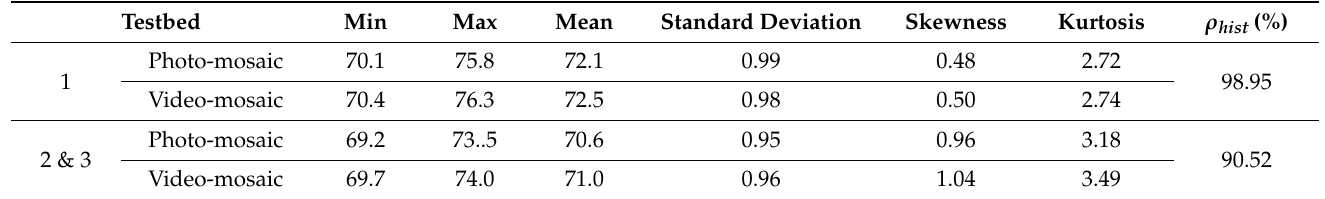
Figure 7. Absolute frequencies. The blue bar is the mean adjusted values of SCSTs of the video photo-mosaic in matched hot spots. The yellow bar is the mean adjusted values of SCSTs of the photo-mosaic in matched hot spots. ( a ): Testbed 1; ( b ): Testbeds 2 and 3. Table 6. Descriptive statistics of the histogram with the mean-adjusted SCSTs in matched hot spots between the photo-mosaic and video-mosaic.